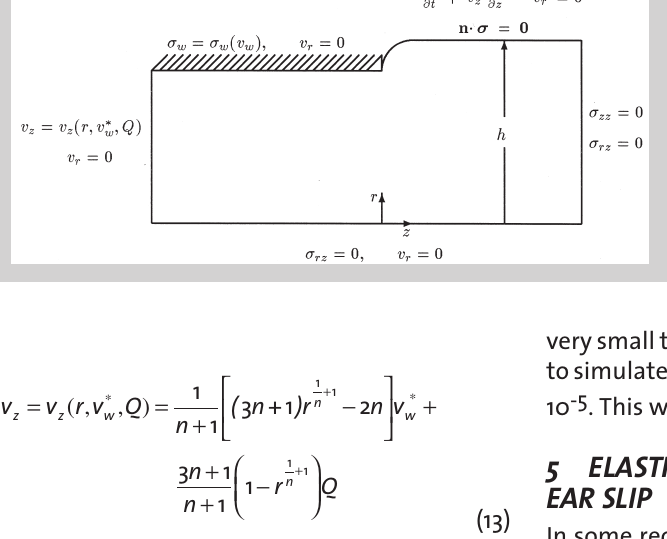
Figure 3 (left): Geometry and boundary conditions for the compressible extrudate- swell flow of a Carreau fluid with slip at the wall.